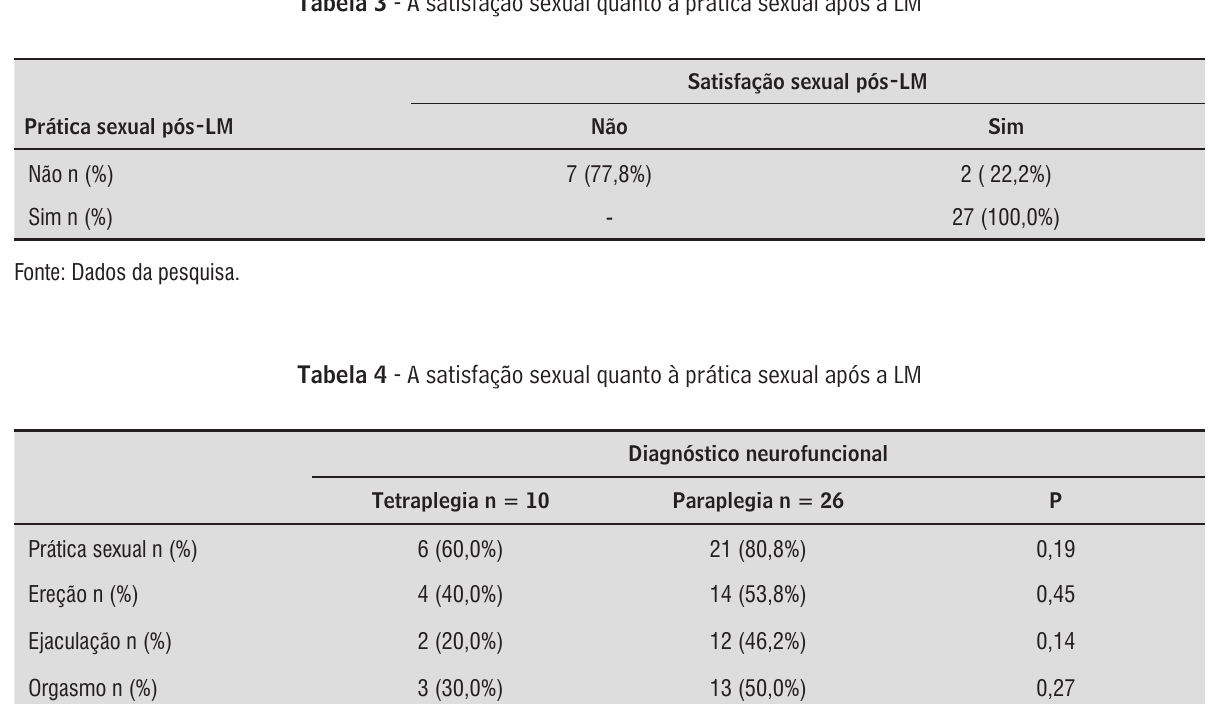
Tabela 3 - A satisfação sexual quanto à prática sexual após a LM